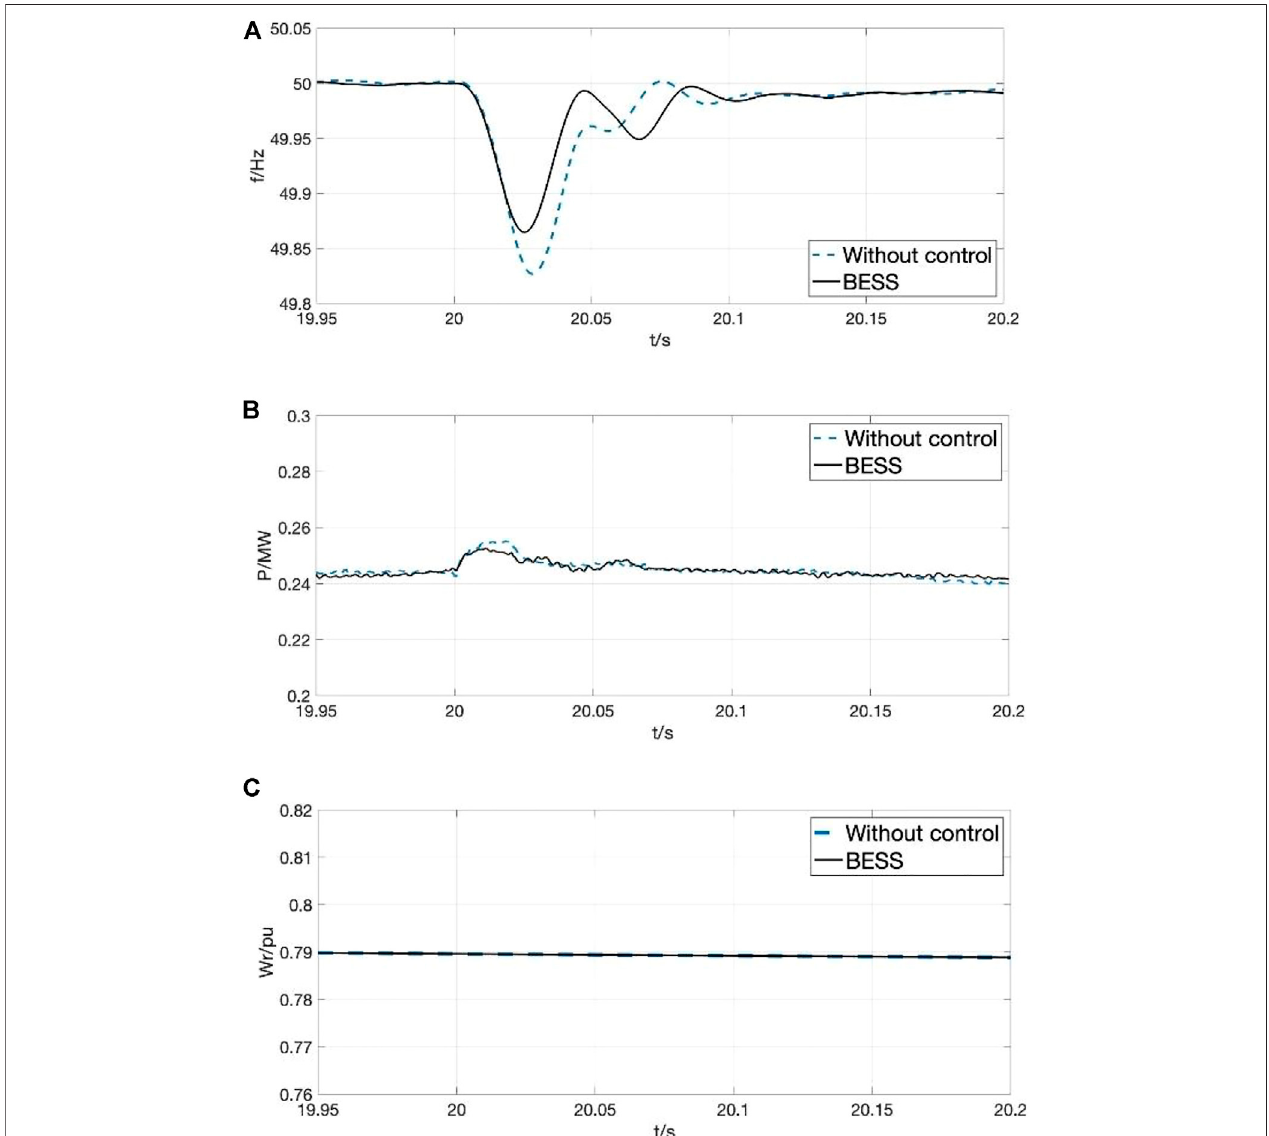
FIGURE 7 | Results for case 1. (A) system frequency. (B) turbine output power. (C) rotor speed of turbine.